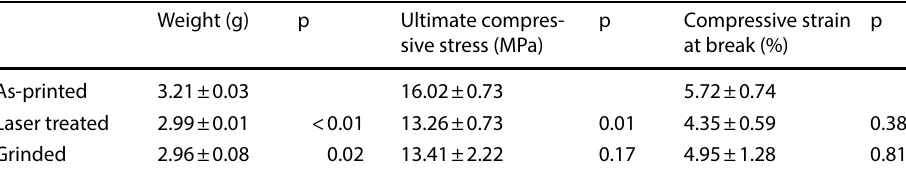
Data represents mean ± SD of triplicates; p test groups compared to as-printed